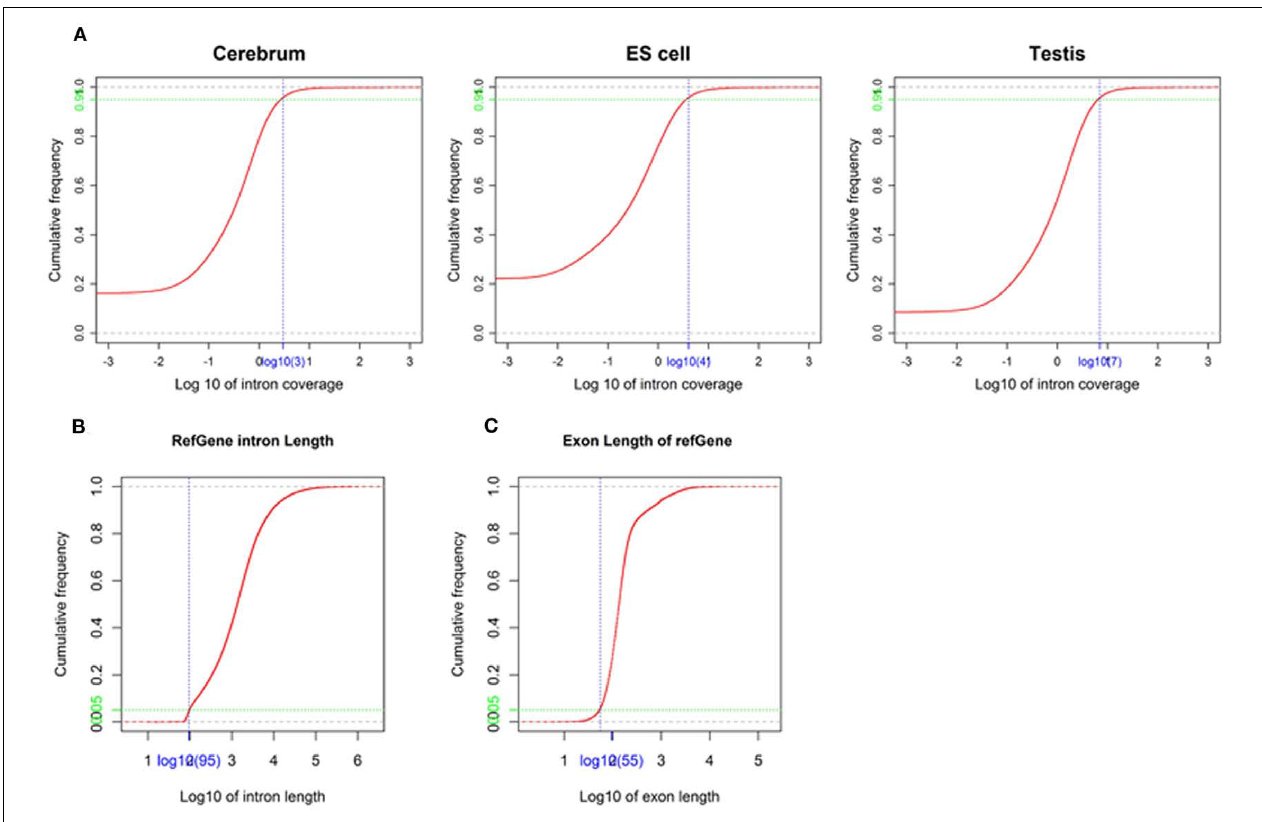
identification.The value (blue) on x -axis is identified as minimal intron length (95) and the value (green) on y -axis is the corresponding accumulative frequency (0.05). (C) The minimal exon length used in exon identification.The value (blue) on the x -axis is identified as minimal exon length (55) and the value (green) on the y -axis is the corresponding accumulative frequency (0.05).